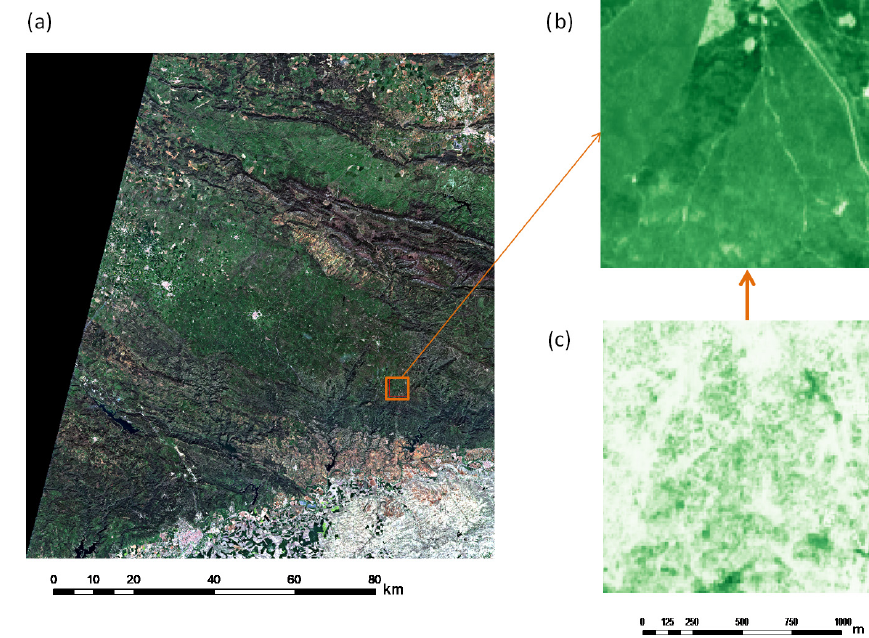
Figure 2. RGB Sentinel-2a image (7 April 2016) (a) , NDVI (7 April 2016) (b) and fcover images (28 July 2017) (c)